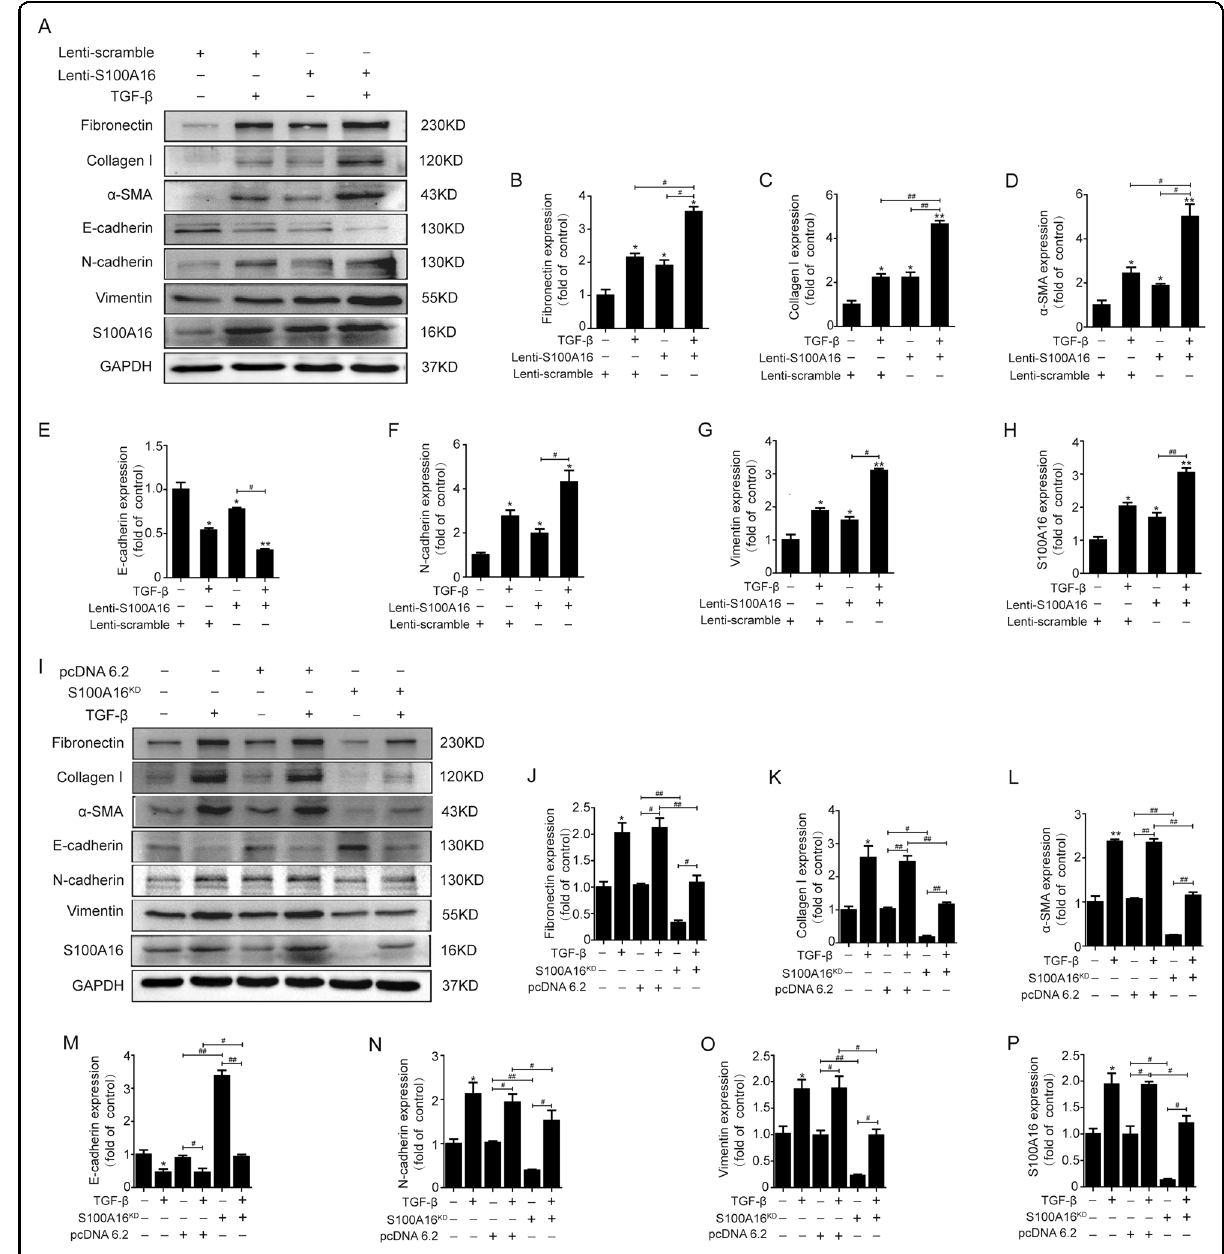
Fig. 3 S100A16 accentuates the TGF- β -induced EMT and fi brogenic effects in HK-2 cells. a – h Representative bands of western blots showing the expression of fi bronectin, collagen I, α -SMA, E-cadherin, N-cadherin, vimentin, and S100A16 in lenti-scrambled and lenti-S100A16 virus-treated HK-2 cells. * p < 0.05, ** p < 0.01 vs. scrambled; # p < 0.05, ## p < 0.01. i – p . Representative bands of western blots showing the expression of fi bronectin, collagen I, α -SMA, E-cadherin, N-cadherin, vimentin, and S100A16 in normal, vector-transfected, and S100A16 KD HK-2 cells. * p < 0.05, ** p < 0.01 vs. normal controls; # p < 0.05, ## p <